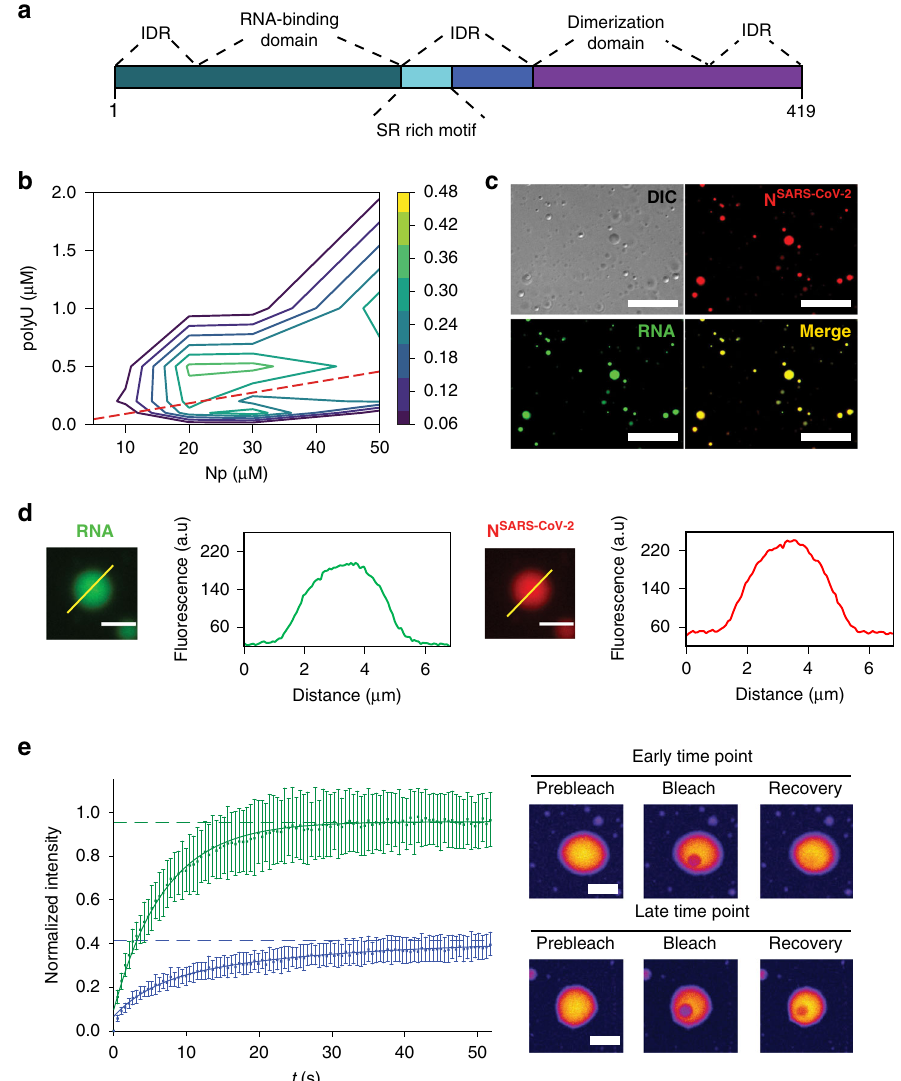
Fig. 1 RNA-induced LLPS of the nucleocapsid protein of SARS-CoV-2. a Organization of N SARS-CoV-2 into two globular domains (RNA-binding domain and C-terminal dimerization domain) surrounded by long intrinsically disordered regions (IDR) 4,5 . The serine/arginine (SR)-rich region is conserved in coronaviruses. b In fl uence of RNA and protein concentration on N SARS-CoV-2 /polyU-LLPS in 20 mM NaPi, pH 7.5, monitored by solution turbidity at 350 nm. Average values from three independent measurements are shown. The dashed line marks N SARS-CoV-2 /polyU-concentrations at which charge neutralization occurs, assuming a charge of − 1 per phosphate group. c Fluorescence and DIC microscopy of spherical droplets of 50 µ M N SARS-CoV-2 and 1 µ M polyU in 20 mM NaPi, pH 7.5. Fluorescently labeled RNA (green) partitioned into the droplets. Scale bar, 20 µ m. Micrographs are representative of three independent biological replicates. d Increase in N SARS-CoV-2 - and RNA-concentration inside of N SARS-CoV-2 /polyU droplets in 20 mM NaPi, pH 7.5. Scale bars 3 µ m. Micrographs are representative of three independent biological replicates. e Time-dependent change in diffusion of N SARS-CoV-2 inside polyU-induced droplets observed by FRAP. FRAP of freshly prepared droplets is shown in green, and after incubation for one hour in blue. Error bars represent the standard deviation for averaged six curves for each time point. Representative micrographs of a fresh droplet (top) and after incubation for one hour (bottom) before bleaching, after bleaching, and at the end of recovery are displayed to the right. Scale bars 10 µ